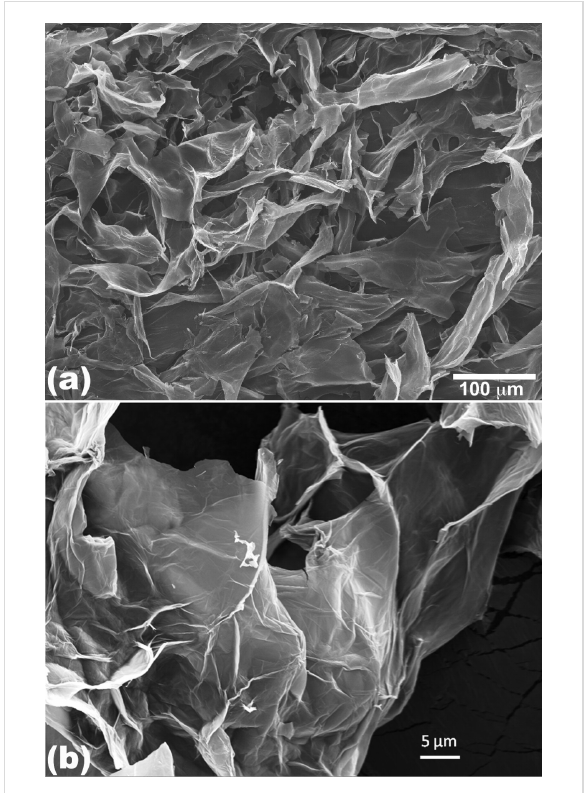
Figure 1: (a) Low magnification and (b) high magnification SEM images of graphite oxide